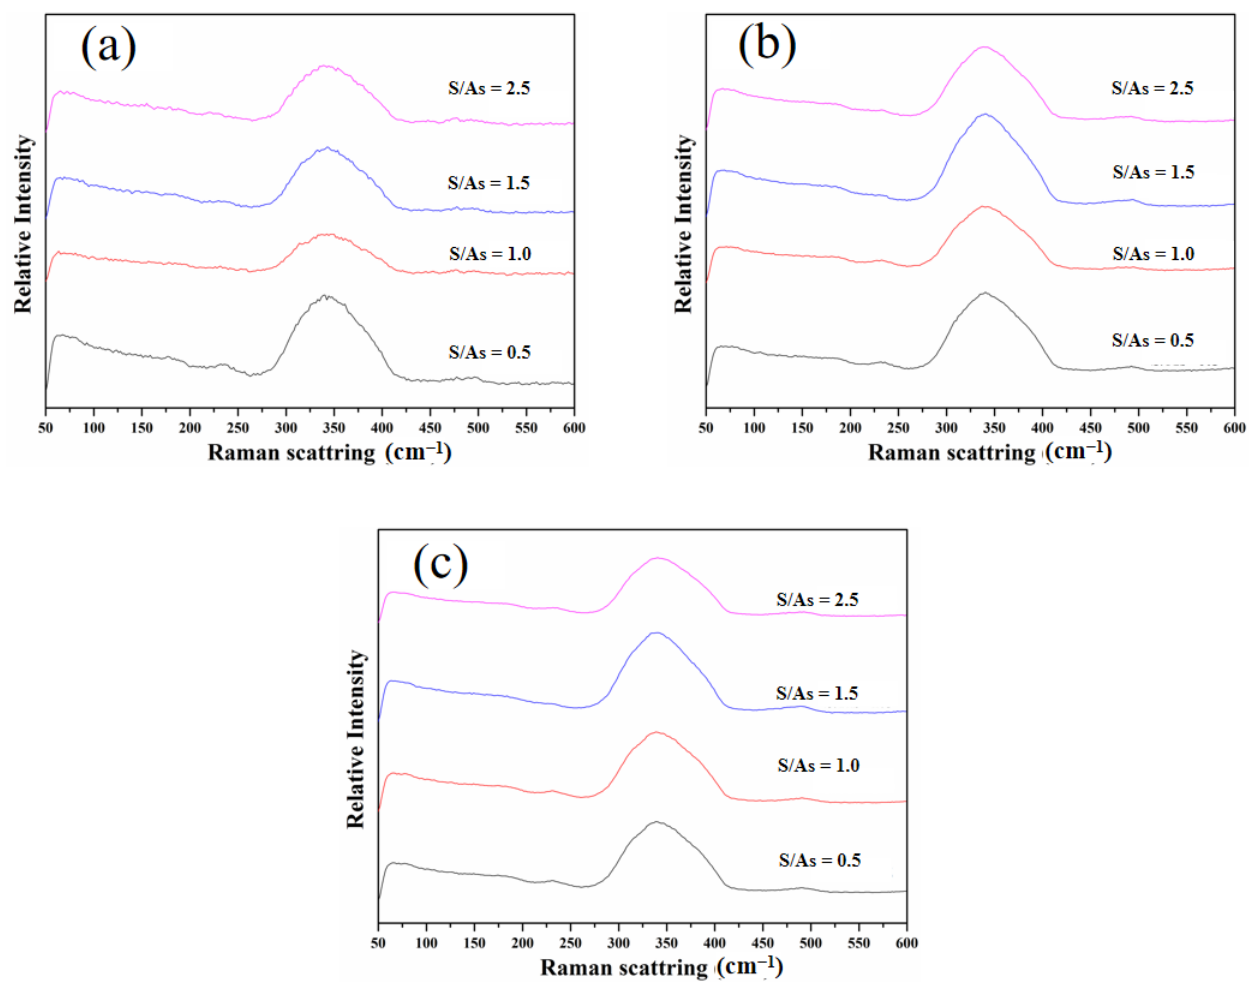
Figure 9. Raman spectra of the precipitates-As(III) for different S(-II)/As(III) at ( a ) 0 ◦ C, ( b ) 30 ◦ C, and ( c ) 60 ◦ C.